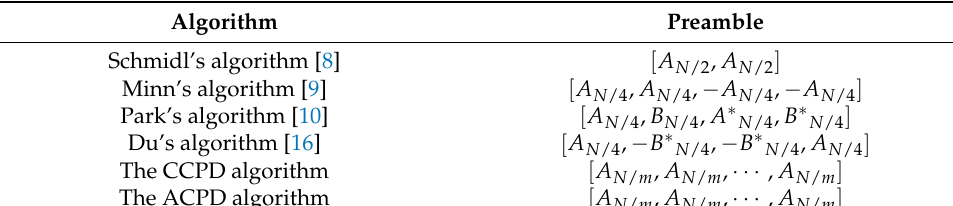
Table 2. The preambles of different algorithms.